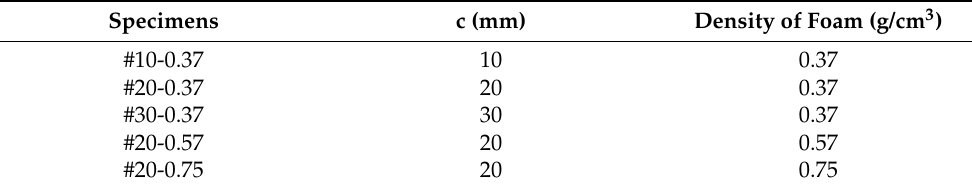
Figure 1. Schematic diagram of three-point bending test. Table 1. Specimen parameters of three-point bending